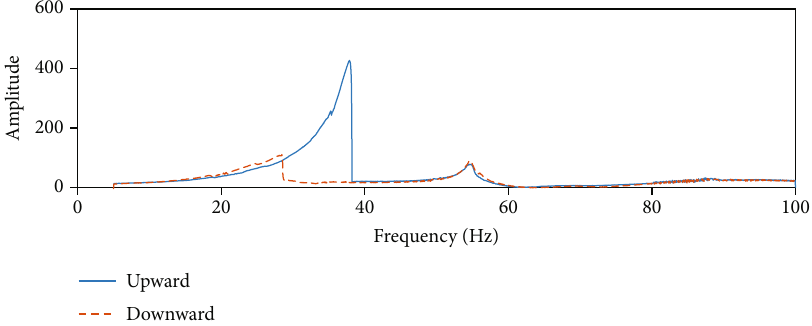
Figure 4: Frequency response characteristics of the folding fi n with freeplay.